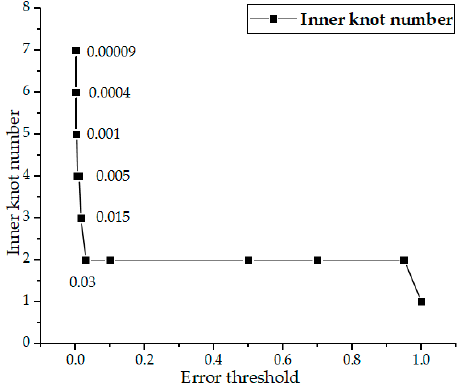
Figure 10. Influence of error threshold on the inner knot number.